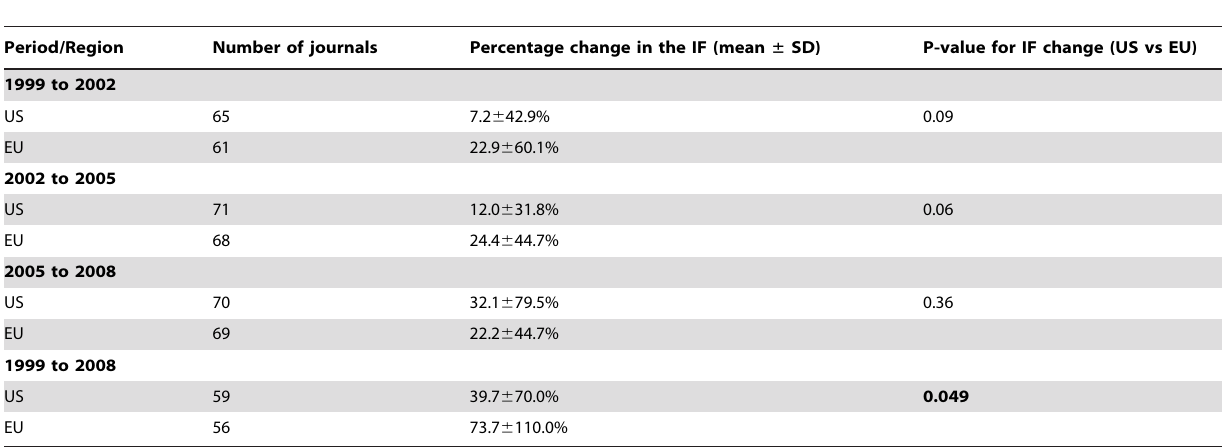
Table 2. Comparison of the change in impact factor of journals in 4 biomedical subject categories published by European vs US biomedical